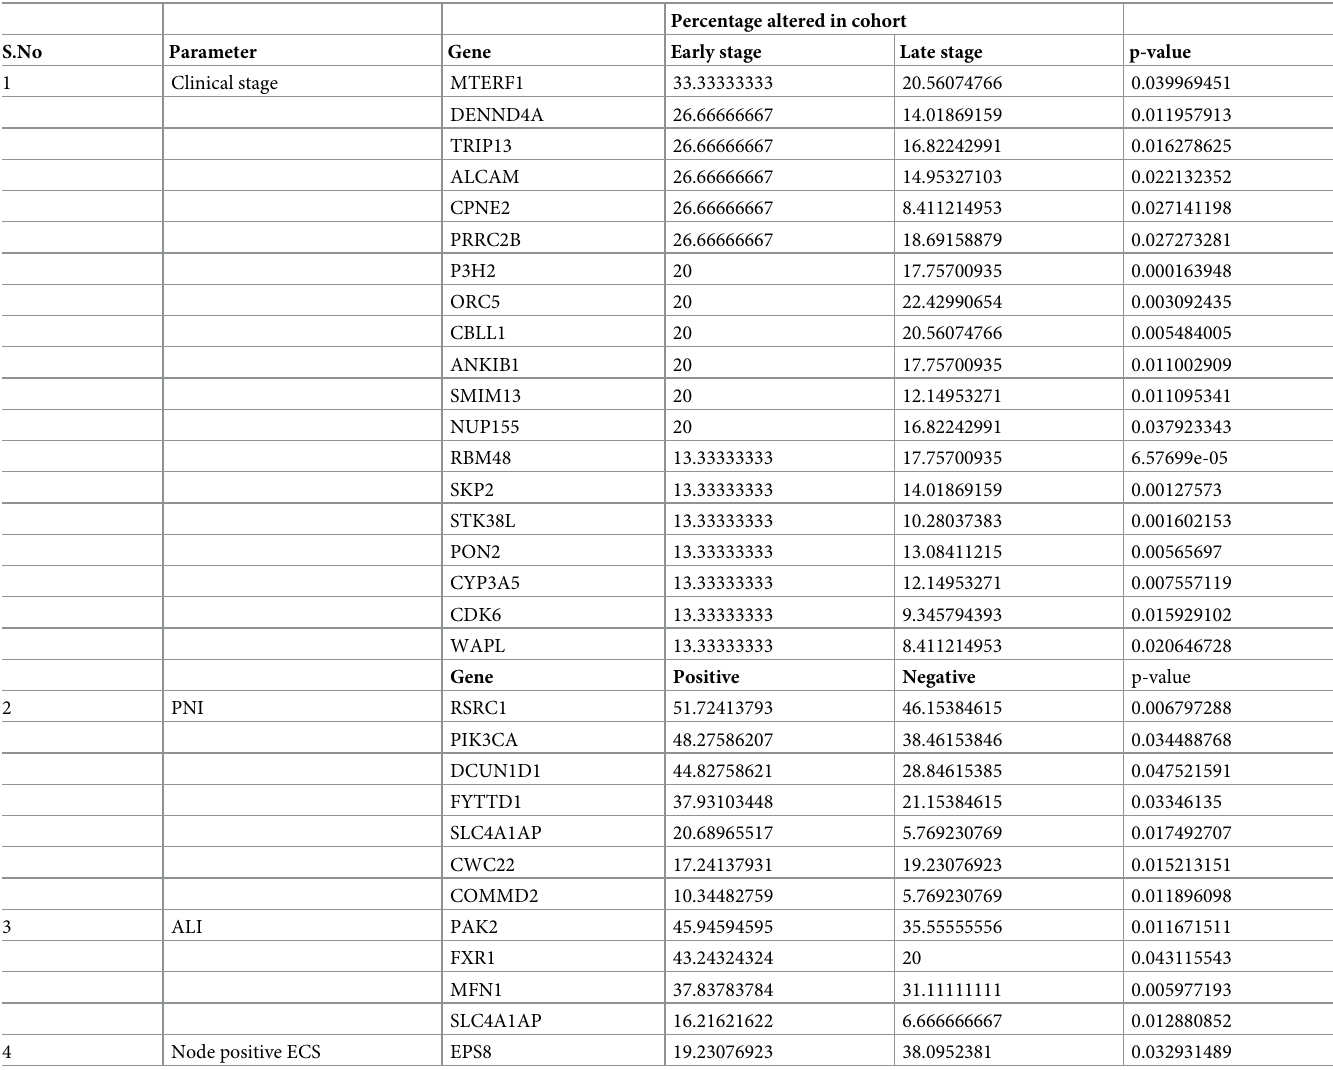
Table 3. Differential mRNA z-score expression profiling between the altered cases in association with clinico-pathological parameters in laryngopharyngeal